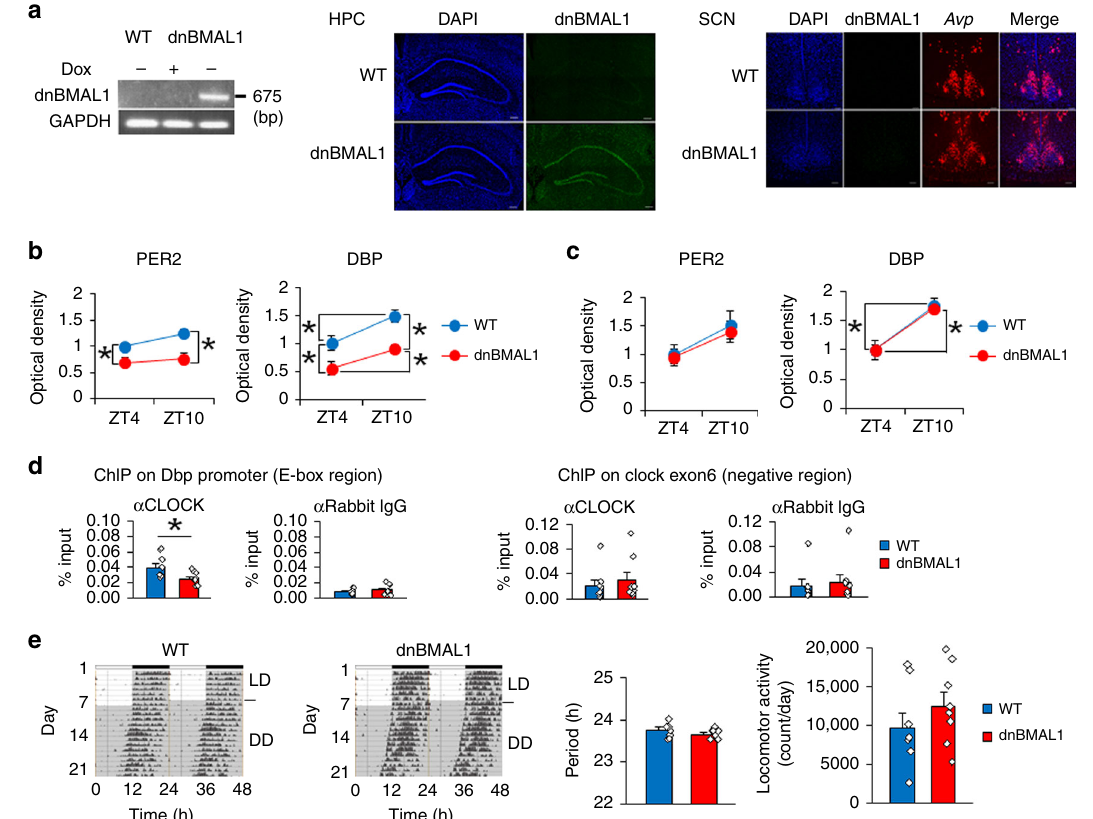
Fig. 2 Forebrain-speci fi c inhibition of BMAL1 function. a dnBMAL1 mRNA expression in dnBMAL1 mice. Dox-dependent dnBMAL1 mRNA expression in hippocampus (RT-PCR, left). dnBMAL1 mRNA expression in hippocampus (HPC, middle) but not SCN (right) (in situ hybridization). AVP mRNA expression as a marker of SCN. DAPI (nuclear stain, blue), dnBMAL1 (green), AVP (red). Scale bar, 200 μ m (HPC) and 100 μ m (SCN). b , c PER2 and expression levels (BMAL1 target genes) are reduced in hippocampal CA1 ( b ) but not in SCN ( c ), in dnBMAL1 mice at both ZT4 and 10. The graph represents fold changes compared to the expression levels in WT at ZT4. d dnBMAL1 blocks the CLOCK binding to Dbp promoter in the hippocampus of dnBMAL1 mice at ZT10. Anti-CLOCK antibody, but not anti-IgG, precipitated DBP promoter although DNA regions not containing E-box ( clock gene exon 6) are comparably precipitated by anti-CLOCK antibody and anti-IgG. e Normal circadian locomotor rhythm in dnBMAL1 mice. Mice were housed in a 12 h light:12 h dark (LD) cycle then in constant darkness (DD). (Left) Representative activity records are double-plotted with each horizontal line representing 48 h. Circadian period (Middle) and daily locomotor activity (Right) under DD. All values are mean ± SEM. Individual data points are displayed as dots. * p < 0.05 as determined by two-way ( b , c ) or one-way ( d , e ) ANOVA with post hoc test. The results of the statistical analyses are presented in Supplementary Table 2. Source data are provided as a source data fi